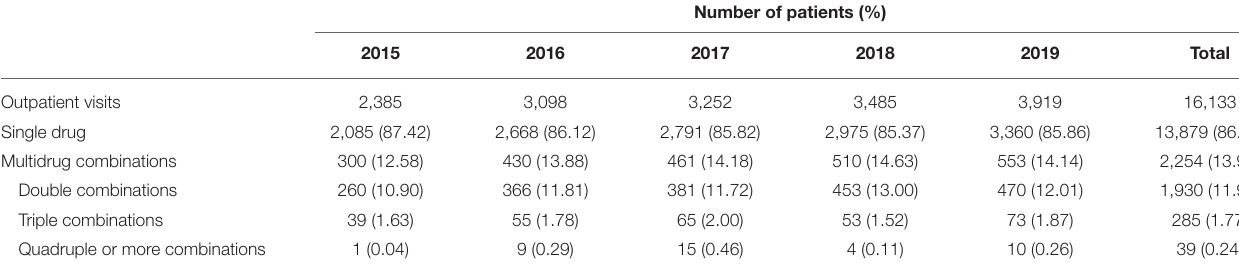
TABLE 6 | Trends of multidrug combinations prescribed in sampled outpatient insomniacs from 2015 to